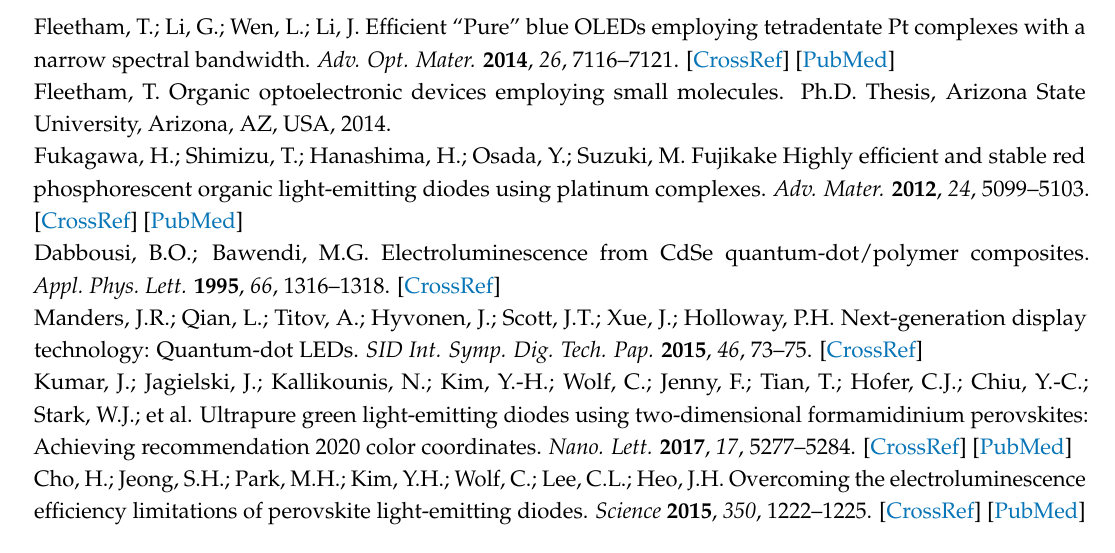
Supplementary Materials: The following is available online, Figure S1: Energy level diagram of the phosphorescent organic light-emitting diodes; Figure S2: Performance of the phosphorescent organic light-emitting diodes with different host materials such as CBP and DIC–TRZ: (a) the luminance–voltage characteristics and (b) the external quantum efficiency–current density curves; Figure S3: The HOMO and LUMO levels of the